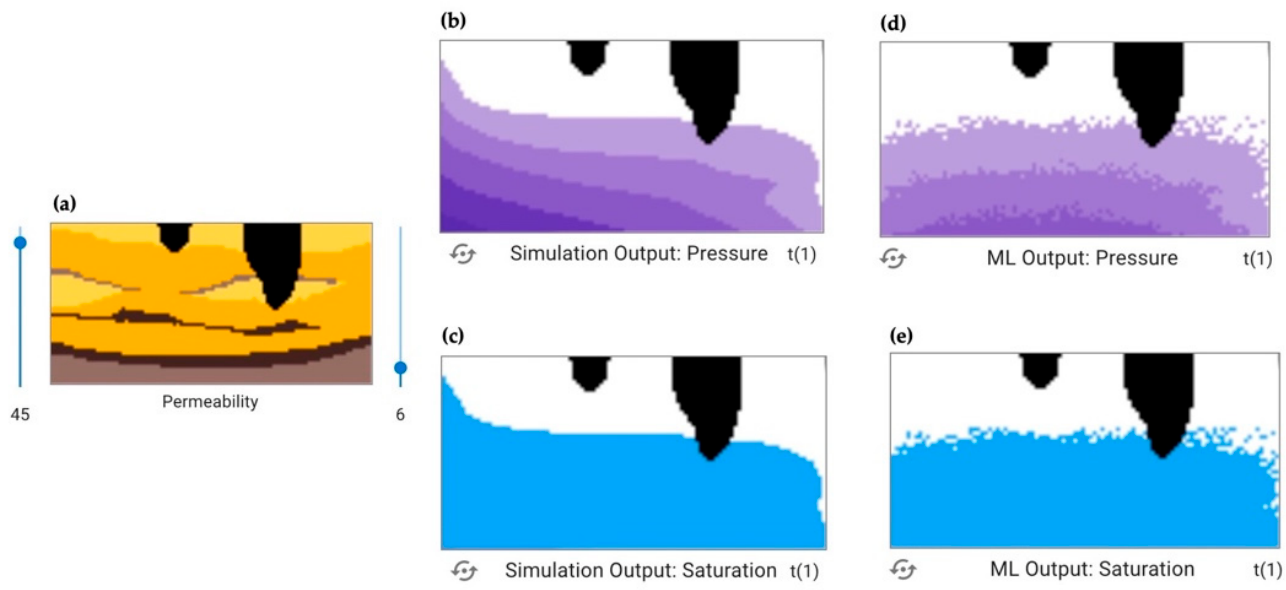
Figure 3. Display of a Sandtank-ML application run, showing ( a ) the input conditions for the simulation, ( b ) the “goal” simulation output for pressure, ( c ) the “goal” simulation output for saturation, ( d ) the ML pressure output using a dry dataset, and ( e ) the ML saturation output using a dry dataset.